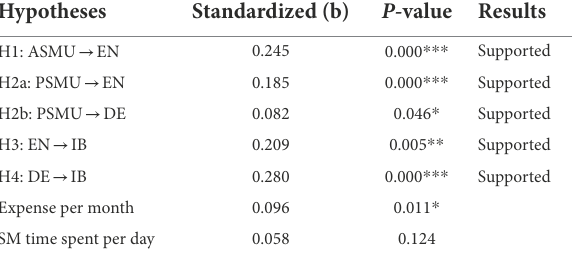
TABLE 4 Path analysis results.